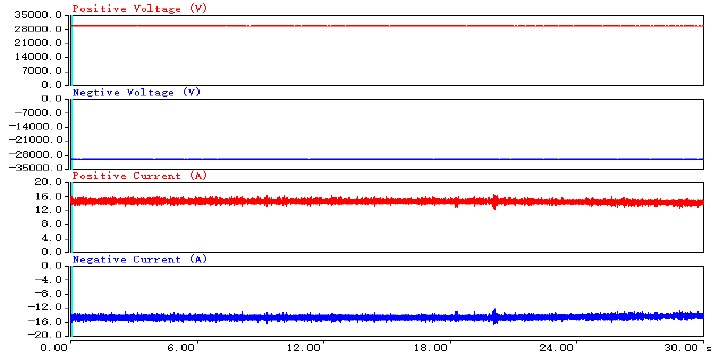
Figure 30. Stable operation waveform of DC/DC converter.